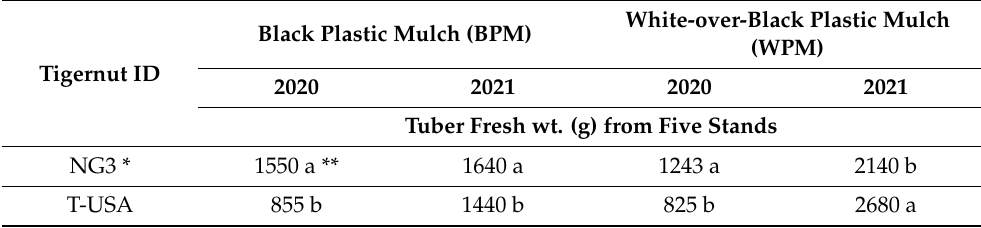
Table 5. Effect of black and white-over-black plastic mulches on tuber yield in the NG3 and T-USA tigernut selections at SPC-F in 2020 and 2021.